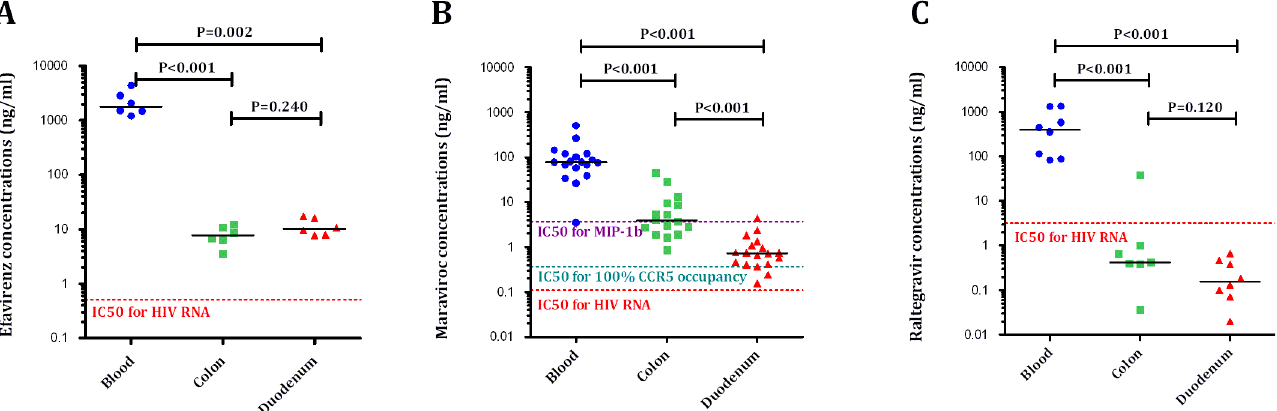
Fig 9. Absolute concentrations in each compartment of efavirenz (A), maraviroc (B) and raltegravir (C) related to the IC50 for HIV-1